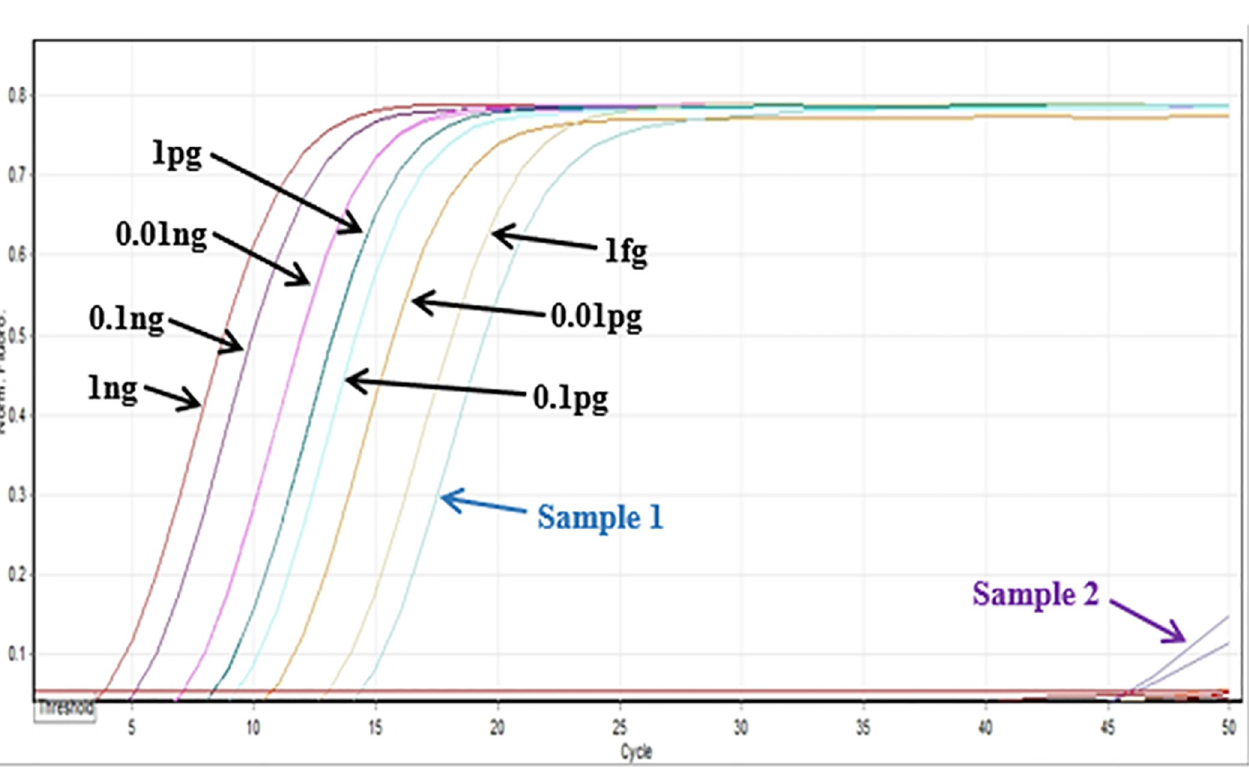
Fig 6. Limit of detection assays RT-qLAMP using GspSSD2.0 DNA polymerase. Limit of detection was made with a ten-fold serially diluted RRV-P3 plasmid starting from 1ng to 1fg and quantification of two unknown RNAs from rose tissue were tested (Sample 1 tested positive).